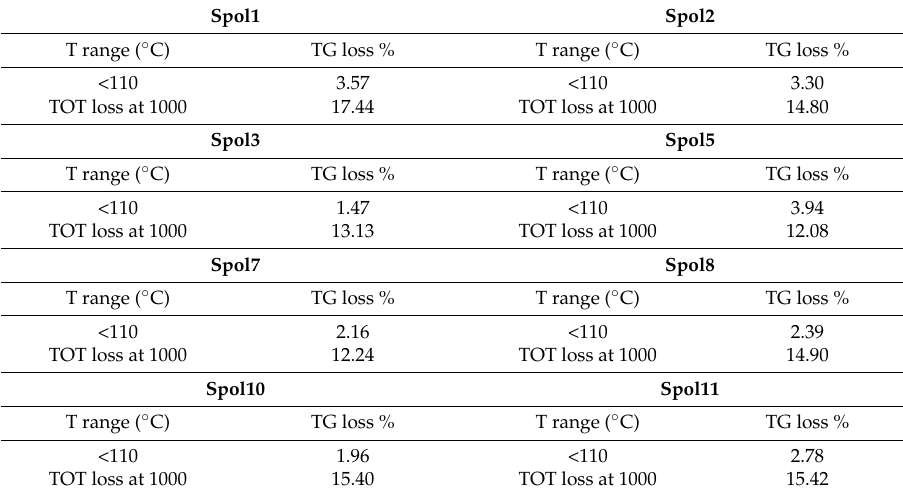
Table 3. TG data (weight loss % up to 110 ◦ C and up to 1000 ◦ C) for the analyzed samples. Spol1 Spol2 T range ( ◦